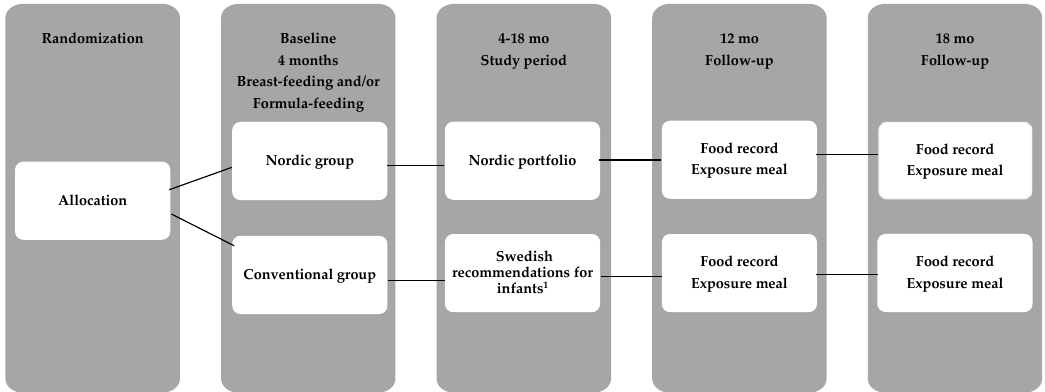
Figure 2. Flow diagram of the study. 1 The Conventional group (CG) parents received written information from the Swedish Food Agency with the current recommendations for infants.